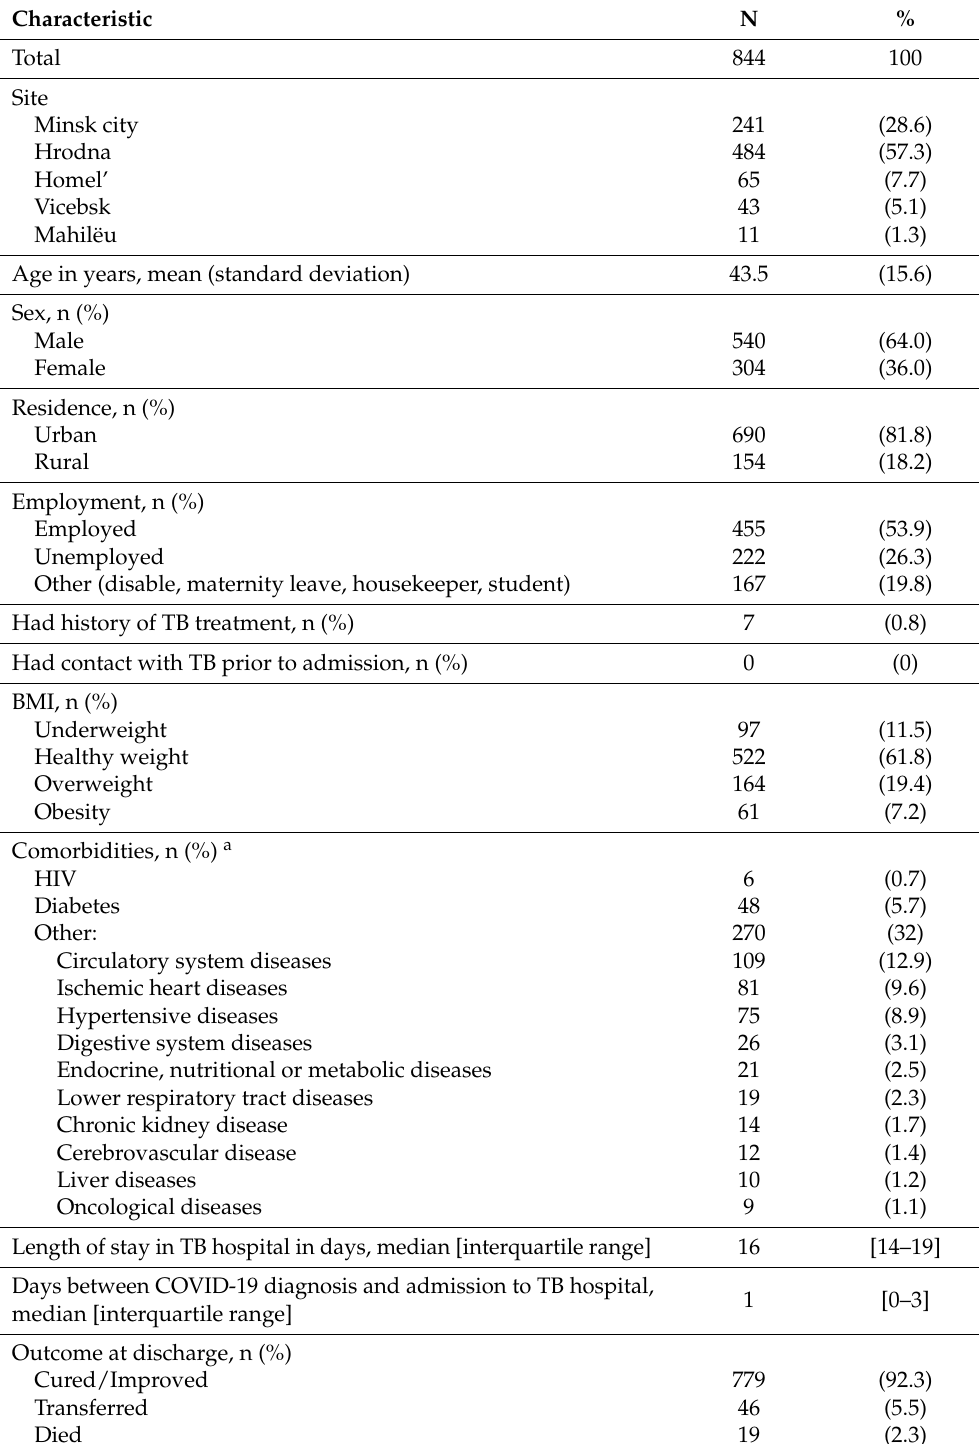
Table 2. Characteristics of patients with COVID-19 admitted to repurposed departments in TB hospitals, Belarus, April–November